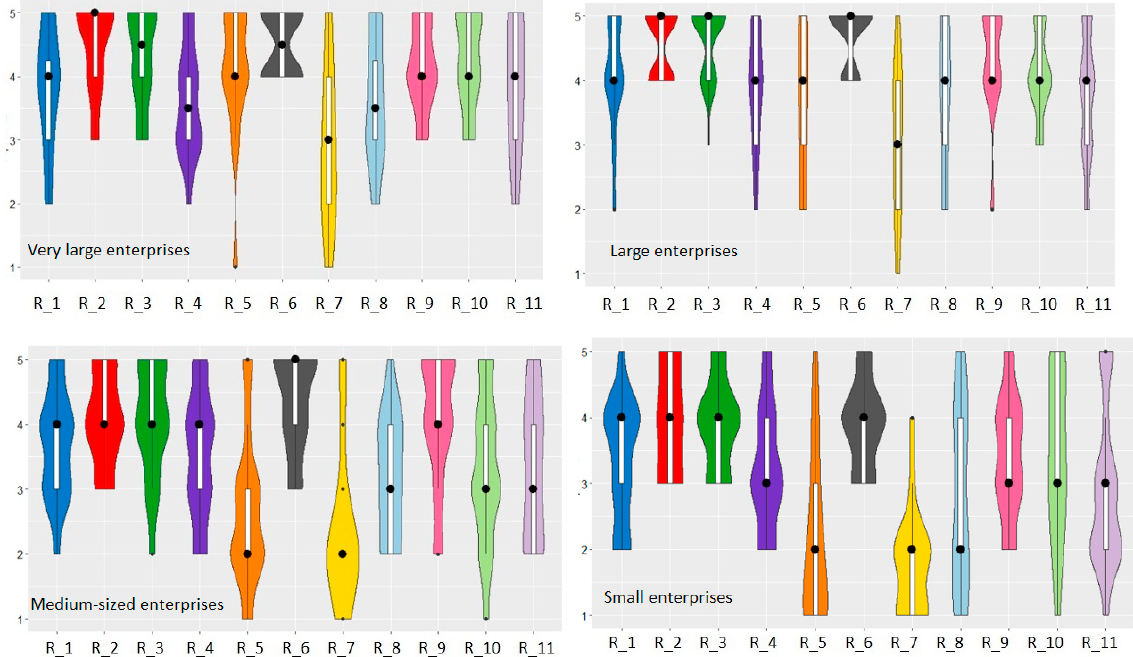
Figure 5. Influence of SM projects on business operations in particular segments of enterprises. Source: own research [73].